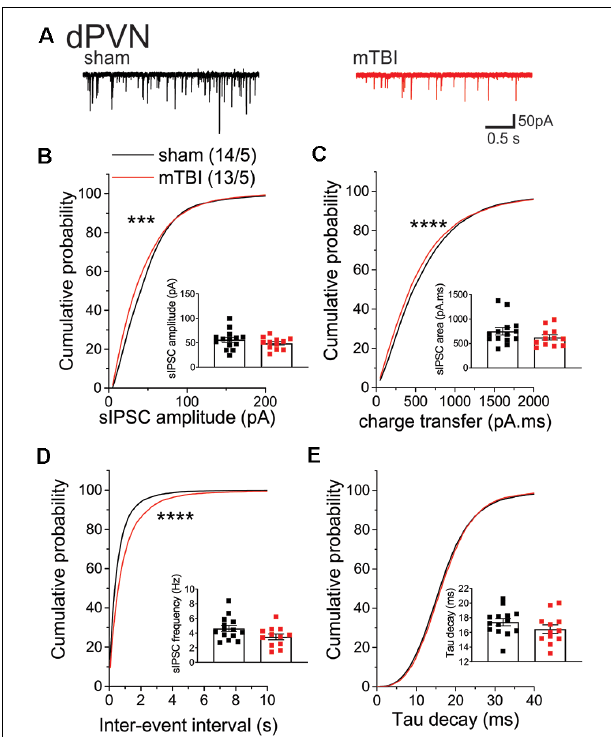
FIGURE 3 | mbTBI significantly decreased spontaneous GABA A R-mediated synaptic transmission onto dPVN CRF neurons. (A) Representative traces of sham (black) and mTBI (red) spontaneous IPSPs (sIPSPs). Cumulative probability (CP) curves and group mean scatter dot-plot of sIPSPs (B) amplitude, (C) charge transfer, (D) inter-event interval (IEI) and (E) Tau decay. KS test for cumulative distribution curves, *** p < 0.001, **** p < 0.0001. Group neuron/mice numbers noted in (B) are identical across other sIPSP